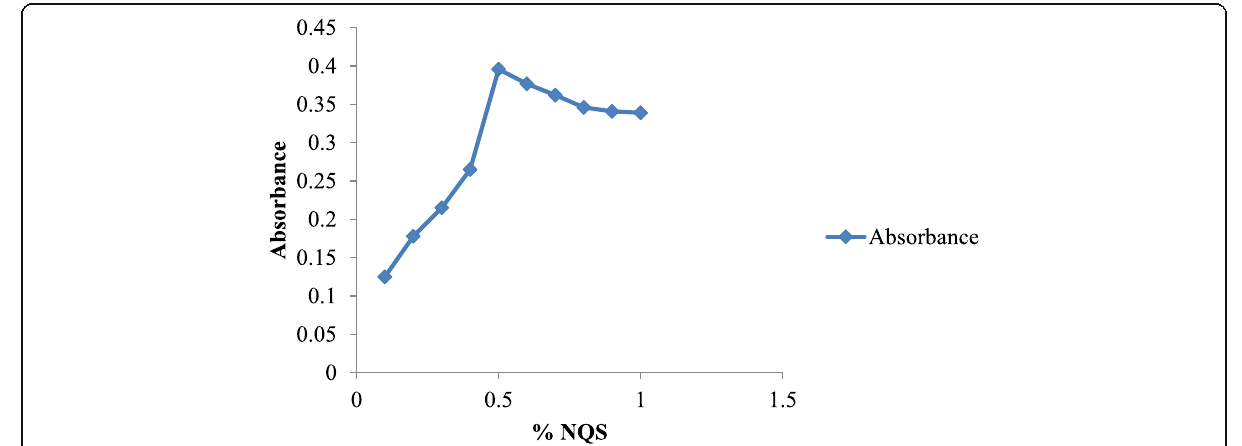
Fig. 6 Effect of concentration of 1, 2-naphthoquinone-4-sulfonate on the reaction